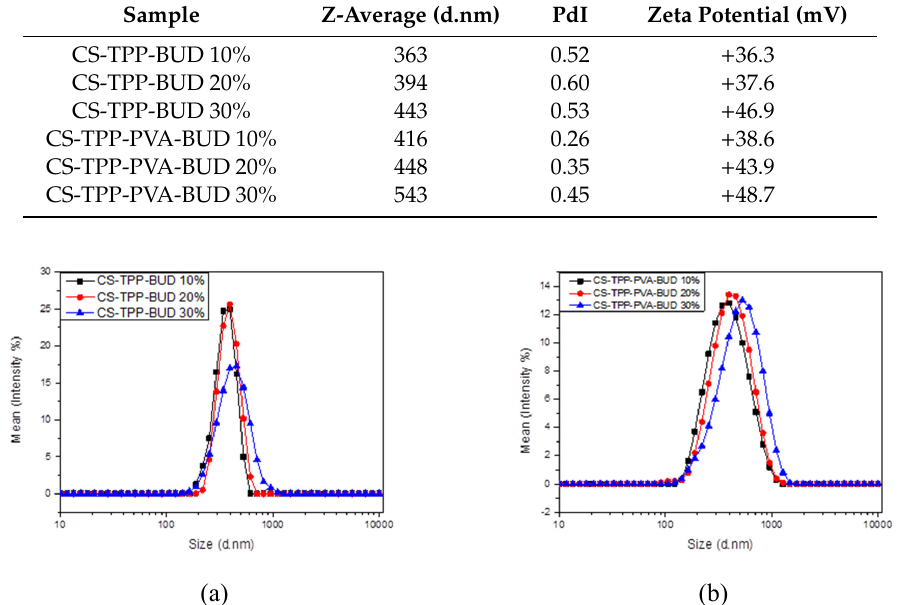
Table 1. Nanoparticles size, polydispersity index (PdI) and zeta-potential results.